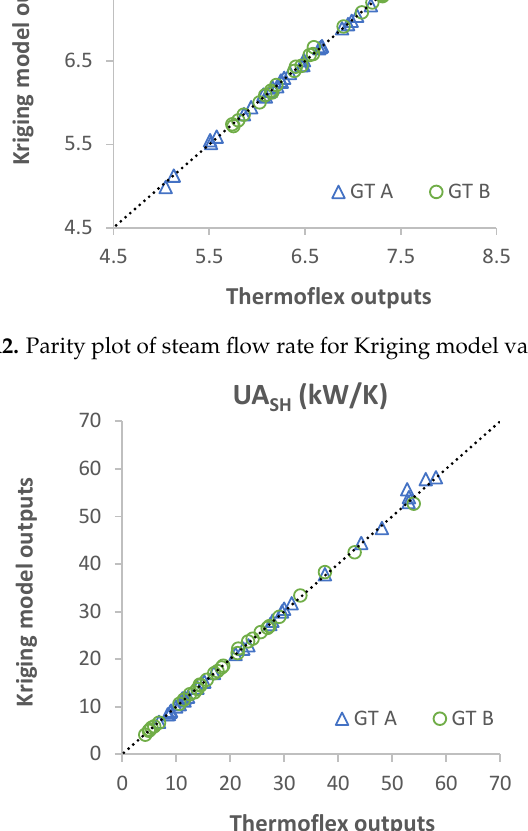
Figure A3. Parity plot UA coefficient of superheater for Kriging model validation.